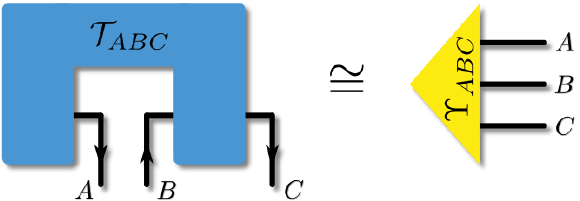
Figure 2: Two-step process. A two step process can be considered (up to normalization) a three-partite quantum state, where each of the parties has a different role. Alice (A) can measure the state of the system at time t can feed forward a state at t , and Charlie (C) can measure the state of the system 1 at t . To emphasize the causal ordering of the process, arrows have been added to 2 the ‘legs’ of the